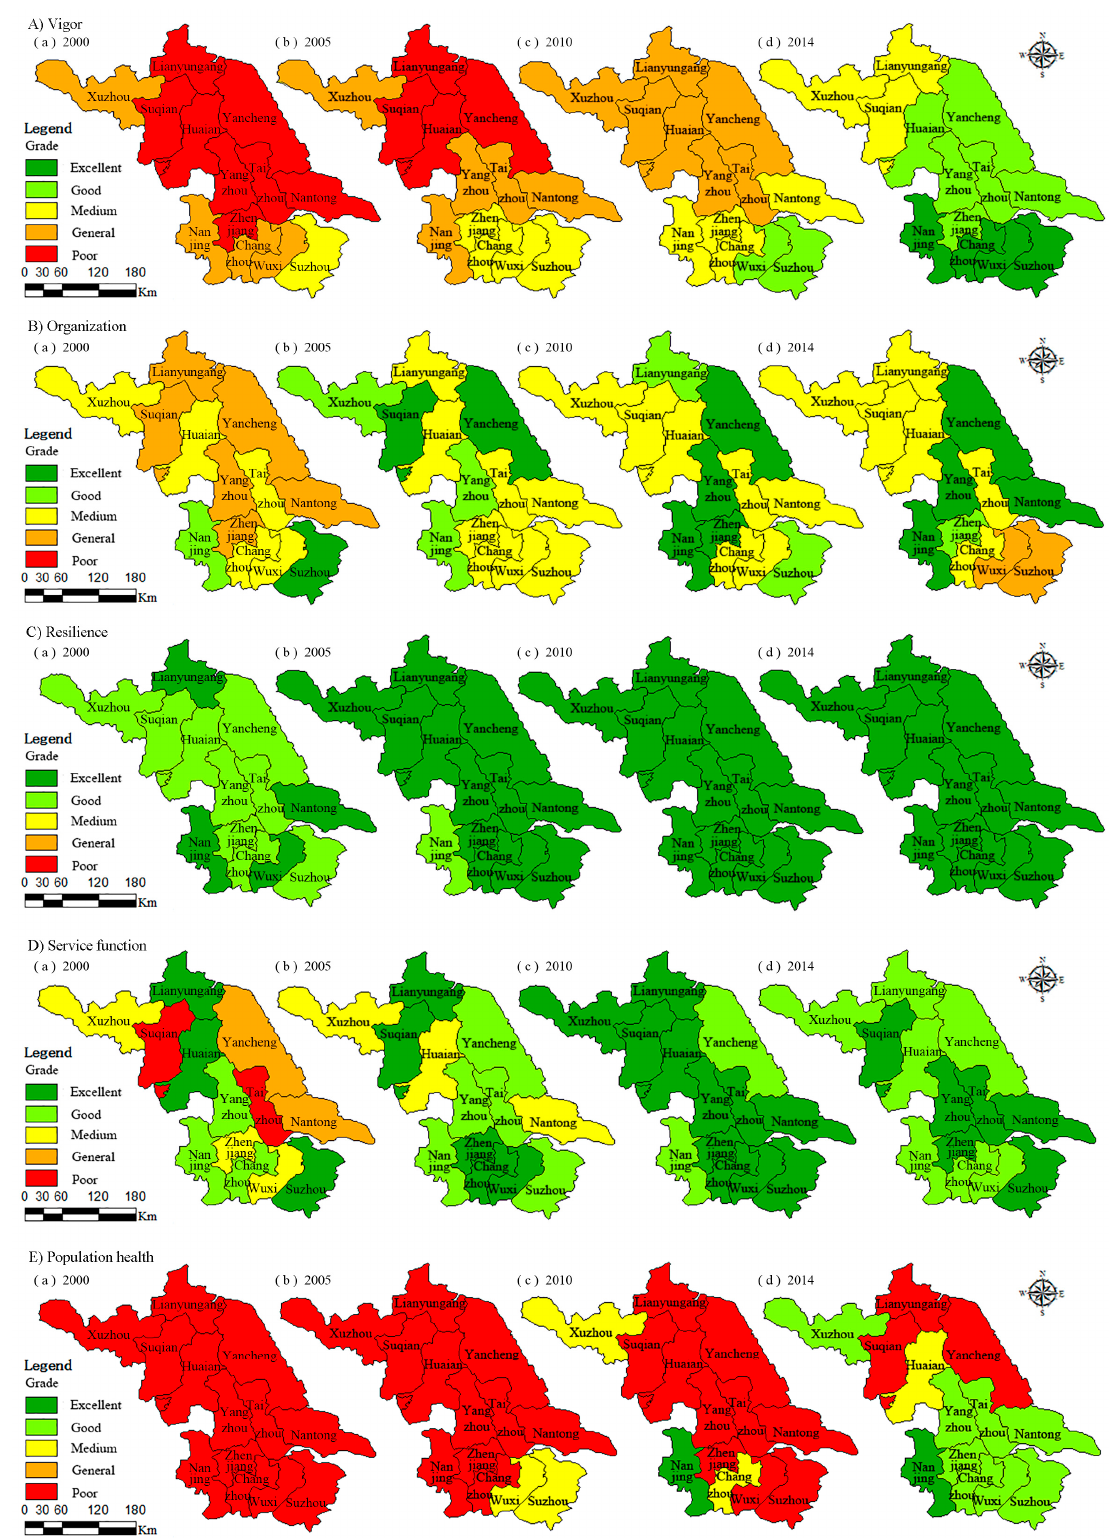
Figure 3. Each component (( A ) Vigor, ( B ) Organization, ( C ) Resilience, ( D ) Service function, and ( E ) Population health) health of UEH in Jiangsu province within 2000, 2005, 2010, and 2014.